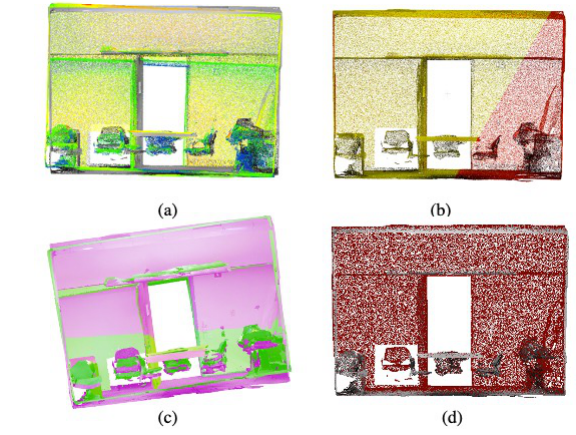
Figure 5. The conference environment. (a) is our method. (b)is the result of ICP. (c) is the result of NDT. (d) is the result of Go-ICP.